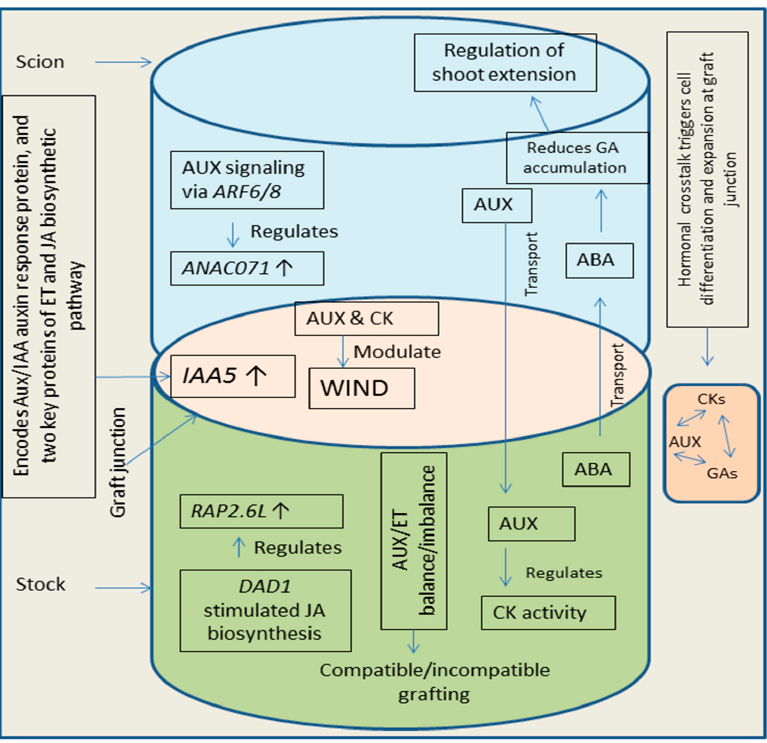
Figure 4. Diagram showing hormonal crosstalk during the process of grafting. It is a conclusion diagram, based on the various studies mentioned in the section related to hormonal